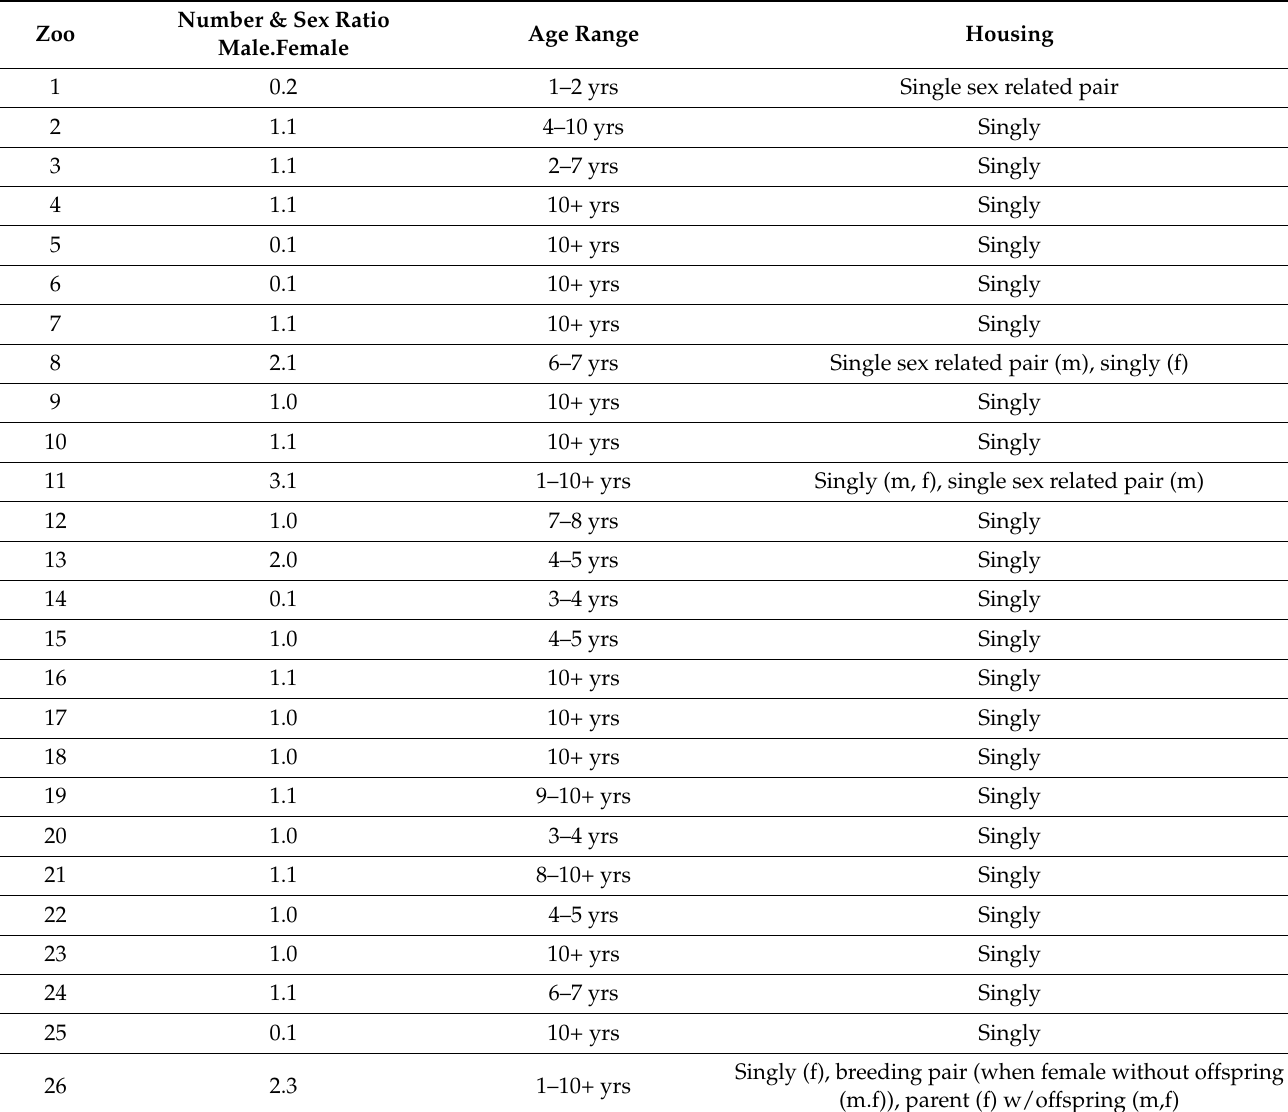
Table 1. Study population of fossa at each zoological collection included in the survey with information relating to the total population, the sex ratio reported as male.female, the age range of animals, and how they are housed (singly, single sex-related, breeding pair, parent w/offspring).